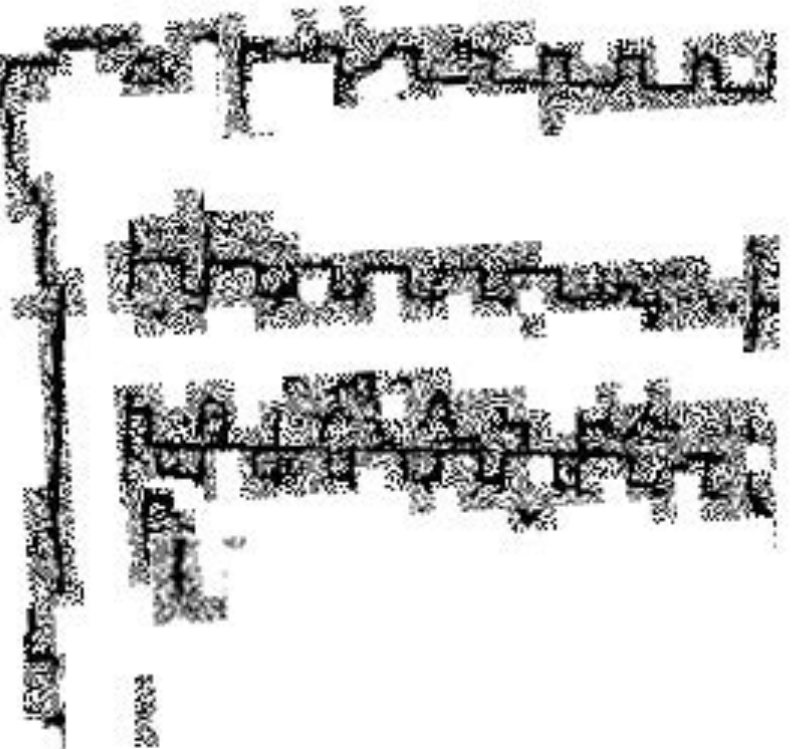
Figure 6. The map corresponding to Euclidean distance matrix ¯ M A